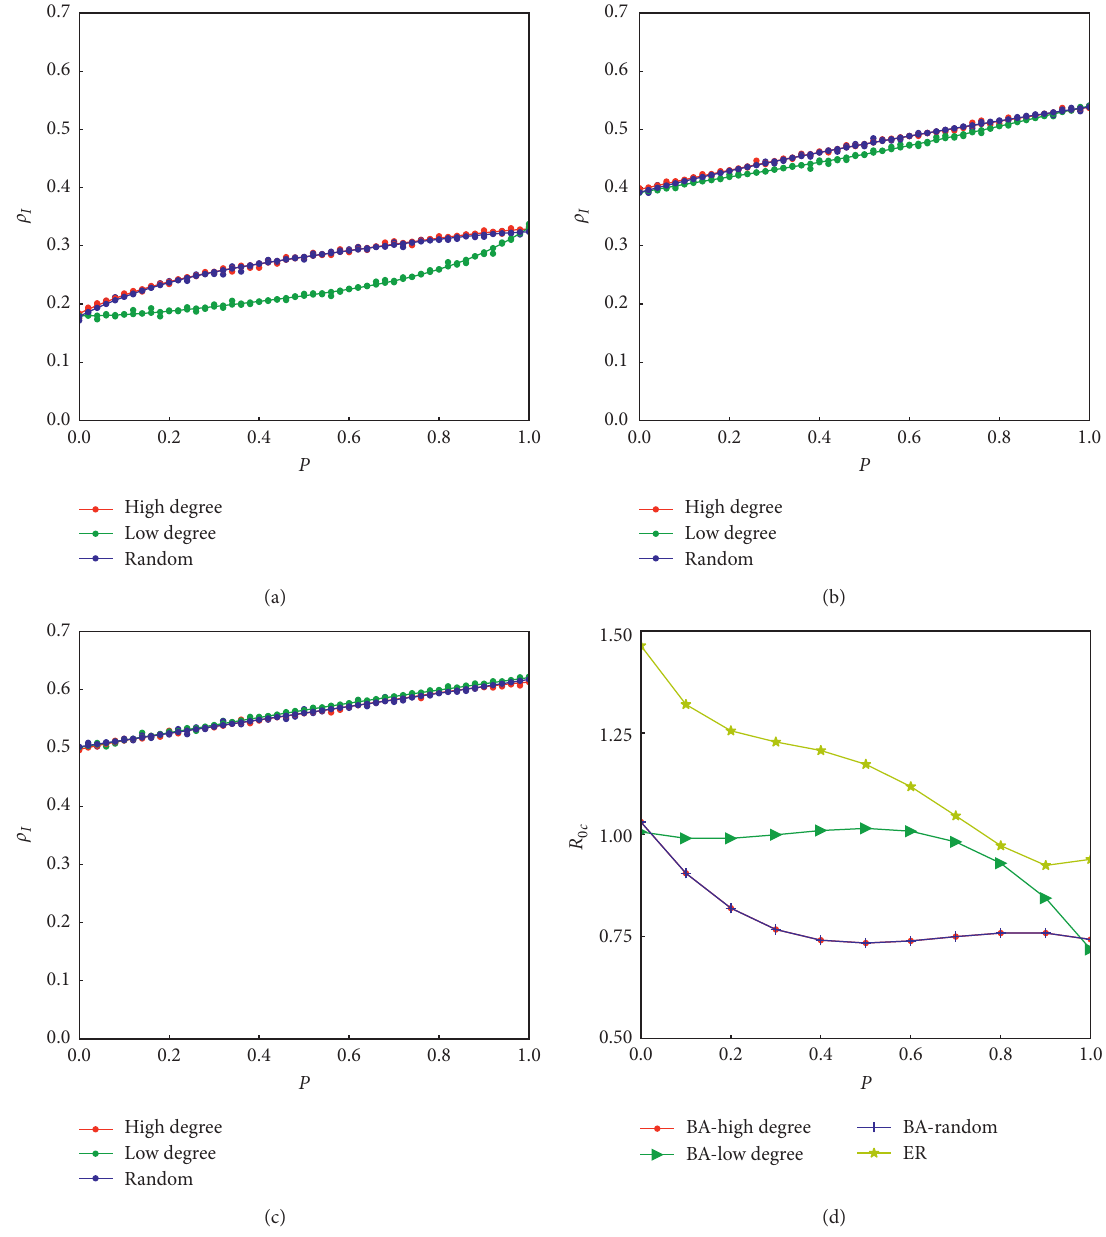
Figure 9: For the first form of dependence, where c � x − ρ A for rational individuals and c � x ρ A for irrational individuals, the dependence of epidemic prevalence ρ I on the ratio of irrational individuals in the BA scale-free network for (a) R Irrational individuals are distributed according to three different strategies: on nodes with the highest degree (red line), on nodes with the lowest degree (green line), and randomly distributed (blue line). (d) The critical infection rate R situations. The parameters are the same as those in Figures 4 and